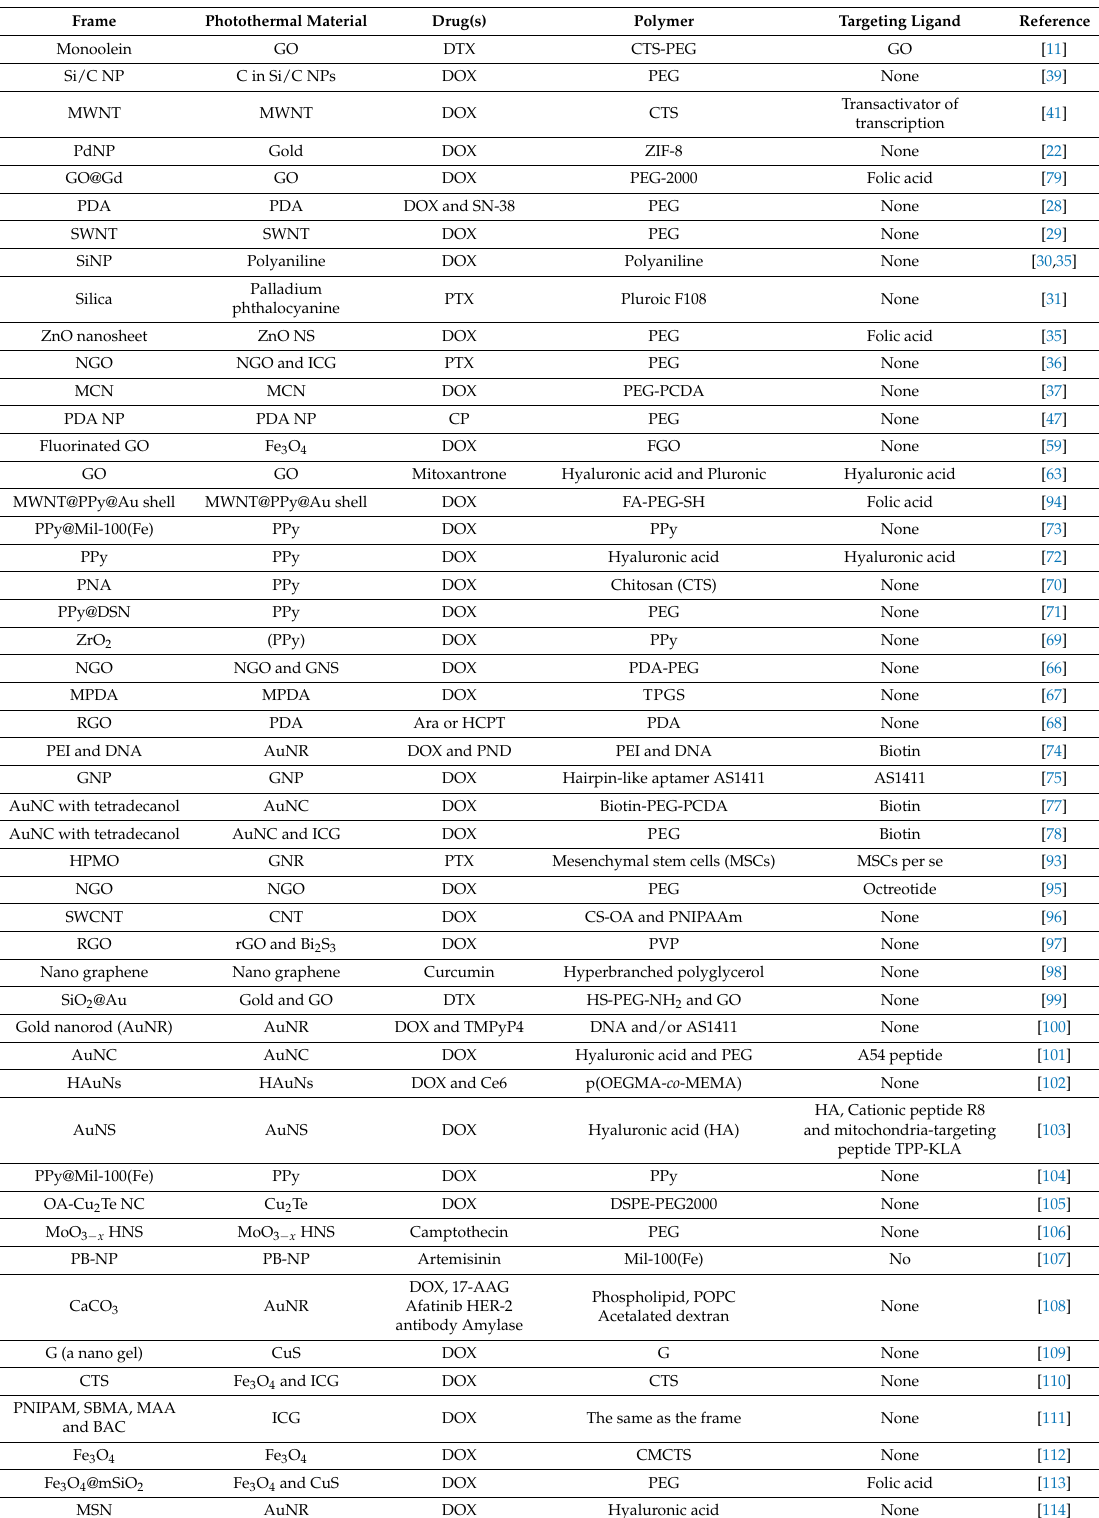
Table 2. List of Frame-Coat Structured